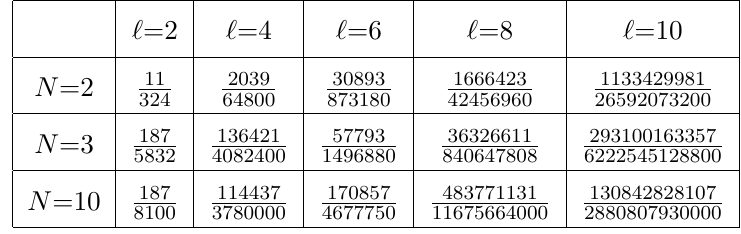
as given in (6.5) . S;‘